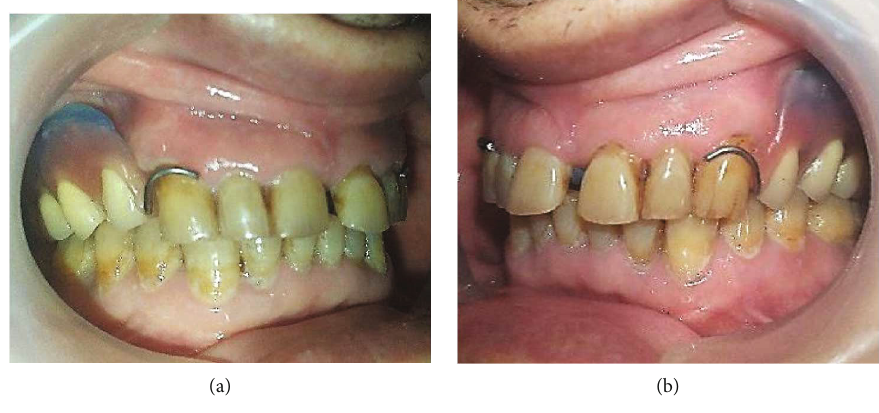
Figure 8: Try-in. (a) Right side. (b) Left side.